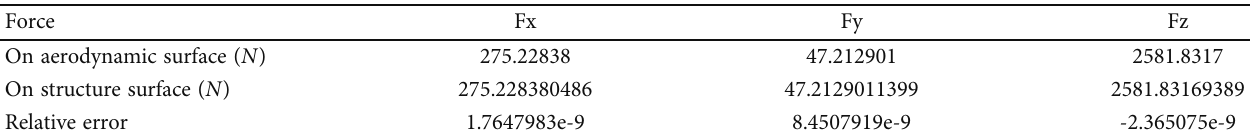
Figure 9: The moment vectors of aerodynamic load interpolated to the structural nodes. Table 1: The comparison of total